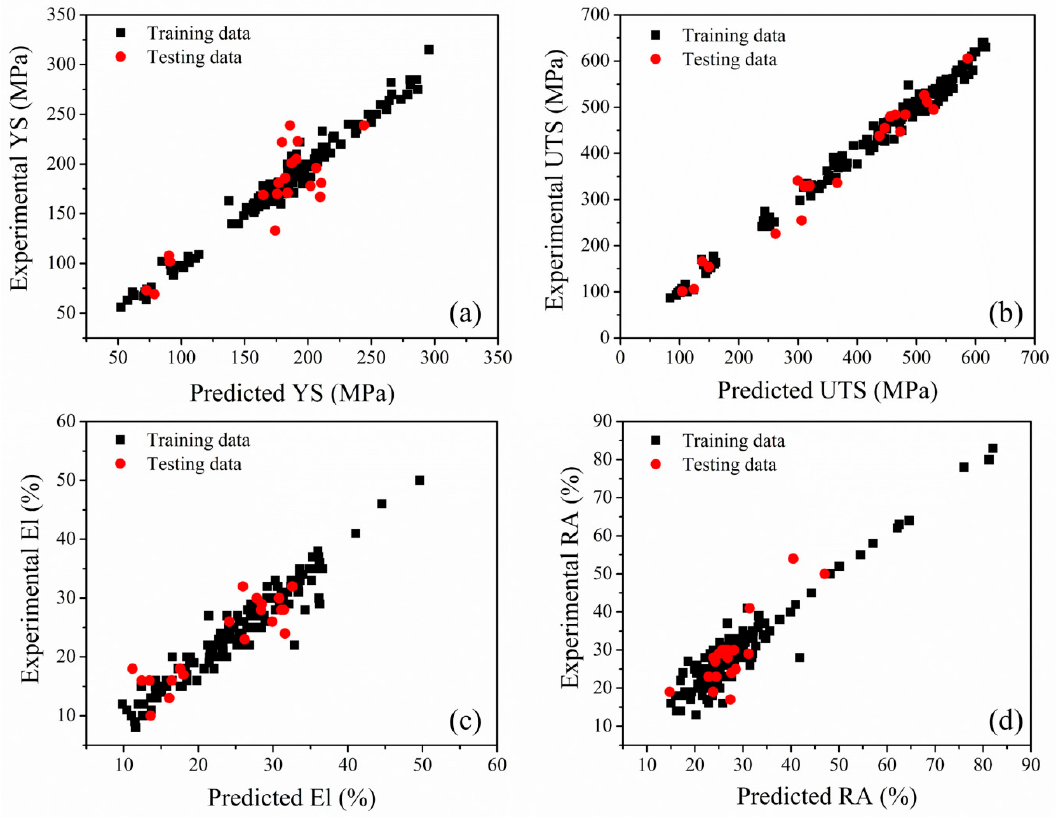
Figure 4. The ability of the neural network model to predict the mechanical properties of 25Cr-20Ni-0.4C steels: ( a ) YS, ( b ) UTS, ( c ) % El and ( d ) % RA of the training and test datasets.